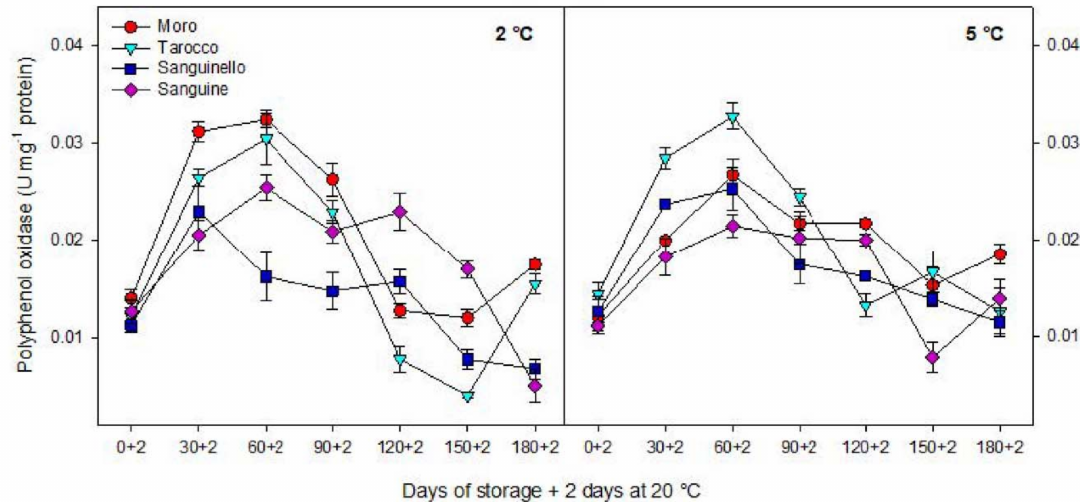
Figure 6. Changes in phenylalanine ammonia-lyase (PAL) and polyphenol oxidase (PPO) enzyme activities in the flavedo of blood orange cultivars (‘Moro’, ‘Tarocco’, ‘Sanguinello’ and ‘Sanguine’) during cold storage at 2 and 5 ◦ C and 90% relative humidity (RH) plus 2 days at 20 ◦ C. Vertical bars represent ± standard error (SE) of means. LSD ( p < 0.05) value is 2.33 for PAL and 0.007 for